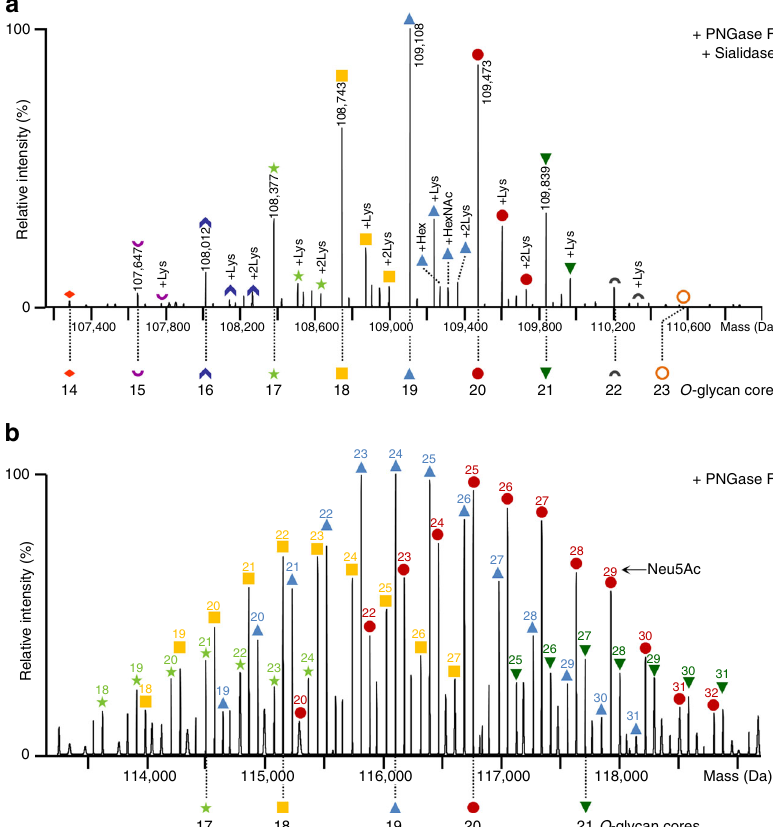
Fig. 2 Annotation of Etanercept O -glycoforms. a Deconvoluted spectrum of Etanercept after digestion with PNGase F/sialidase (raw spectrum shown in Fig. 1h). O -glycoforms, i.e., the number of core 1 units (Hex-HexNAc), as well as lysine variants are annotated. Each symbol indicates a certain number of O - glycan cores. b Deconvoluted spectrum of Etanercept after digestion with PNGase F (raw spectrum shown in Fig. 1f). The number of O -glycan cores is indicated by a speci fi c symbol in accordance with Fig. 2a. Multiple signals annotated with the same symbol represent sialic acid (Neu5Ac) variants of each O -glycoform. The number of Neu5Ac residues is indicated above each annotated peak. Peak lists with all possible glycoform assignments are available